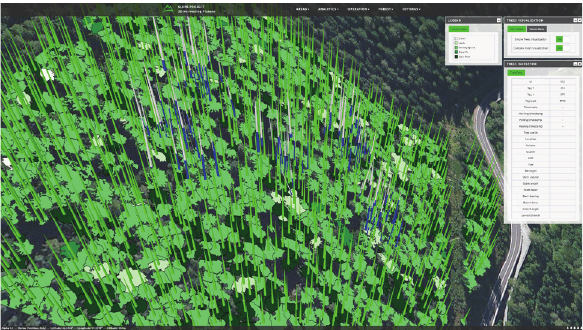
Figure 9: Tree stems reconstructed from terrestrial laser scans